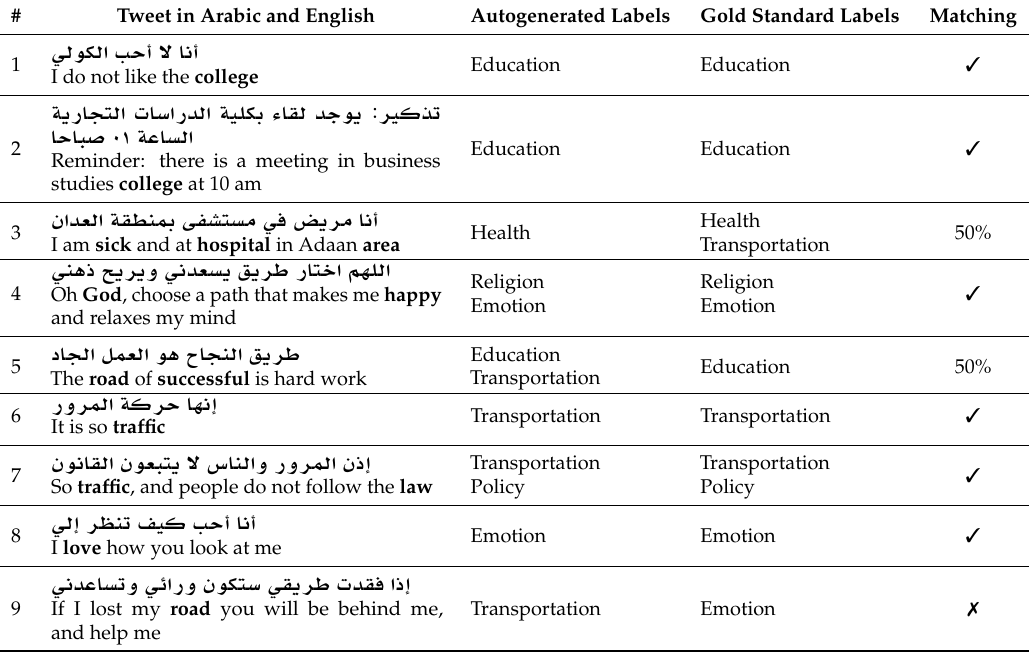
Table 4. An example of manual evaluation process on 1000 autogenerated topical